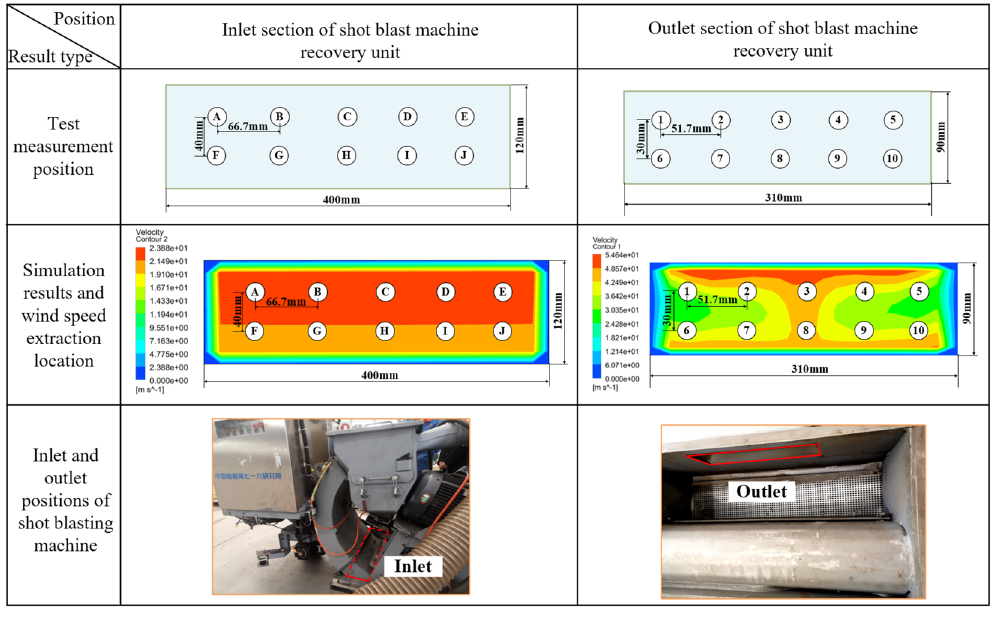
Table 3. Data measurement